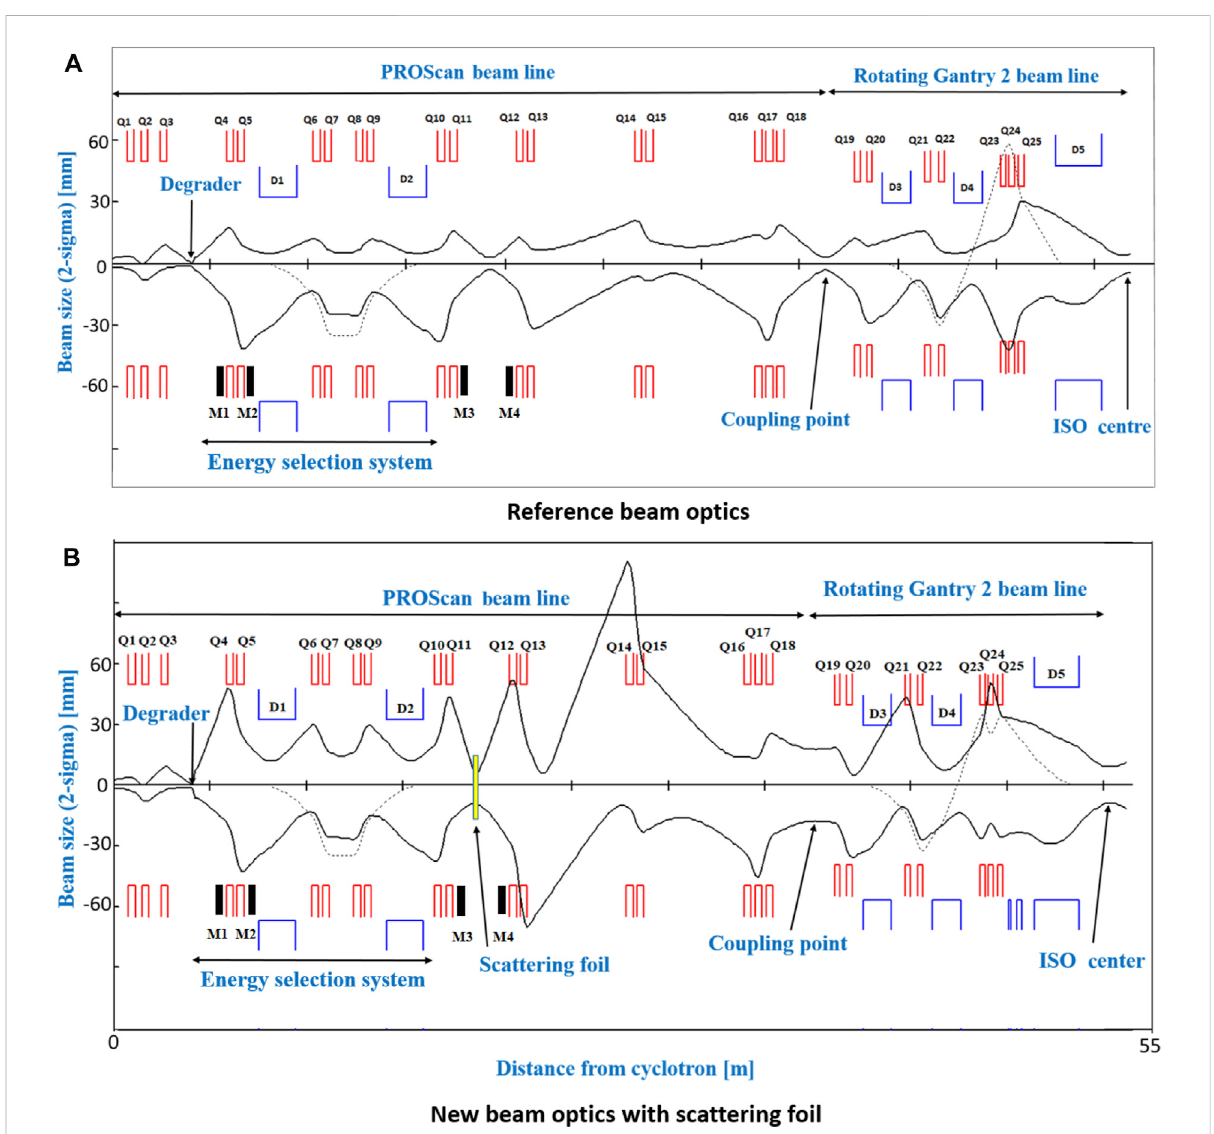
FIGURE 4 (A) Shows reference beam optics transporting 30 π *mm*mrad emittance (in both planes) through beam line and Gantry 2. (B) Shows the new beamopticswithscatteringfoiltransporting67 π *mm*mradinX-planeand139 π *mm*mradinY-planeuptoscatteringfoillocationandtransporting almost 145 π *mm*mrad (in both planes) from scattering foil to isocenter. When the beam envelope (beam size) is larger compared to the quadrupole/dipole aperture, beam lossaccrued at those locations. Q1-Q18 radius is 50 mm and Q19-Q25 radius is 40 mm. The red line below the quadrupole name and the blue line below the dipole name, represent the element aperture (V above and H below the beam axis).